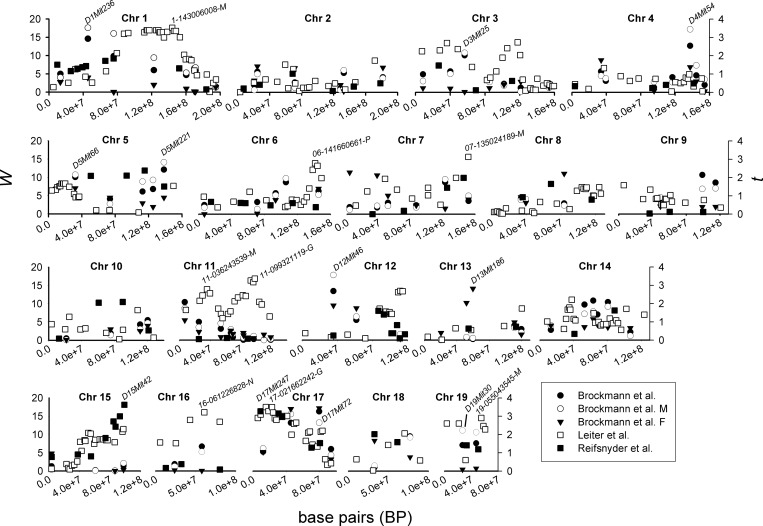
Association mapping of phenotypic dispersion (absolute Studentized residuals from genetic model; ‘PD’) in plasma leptin (PDpLep) on murine chromosomes 1–19 Jackson Laboratory in 402 (228M, 174F) F2 Dilute Brown non-Agouti (DBA/2)×DU6i intercrosses (Brockman et al.), 144 Non Obese Diabetic (NOD/ShiLtJ×(NOD/ShiLtJ×129S1/SvImJ.H2g7) N2 backcross females (Leiter et al.), 204 male Nonobese Nondiabetic (NON)×New Zealand Obese (NZO/HlLtJ) reciprocal backcrosses (Reifsnyder et al.) house mice (Mus musculus).